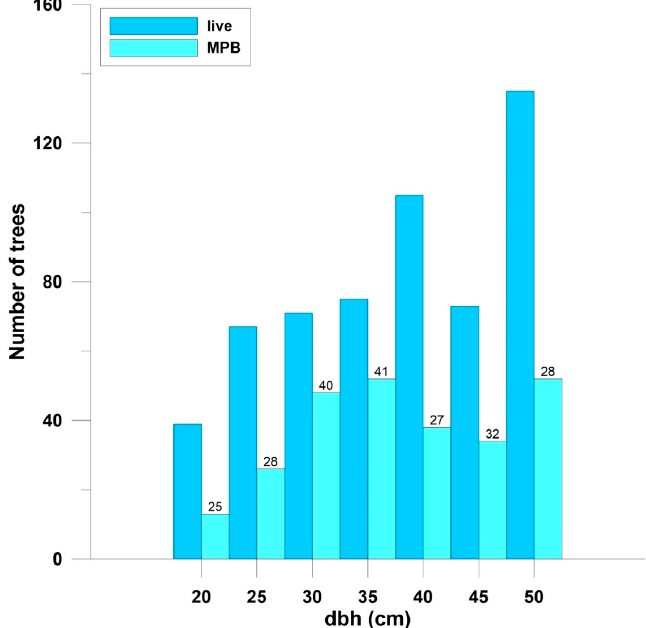
Figure 3. Number of live and MPB-killed ponderosa pine trees across diameter at breast height (dbh) classes. Numbers above MPB bars are the percent of MPB-killed trees per dbh class. The distributions were different; Chi-square = 72.9, df = 10, p < 0.0001. Arapaho-Roosevelt National Forest, Colorado, USA. Insects 2020 , 11 , x FOR PEER REVIEW